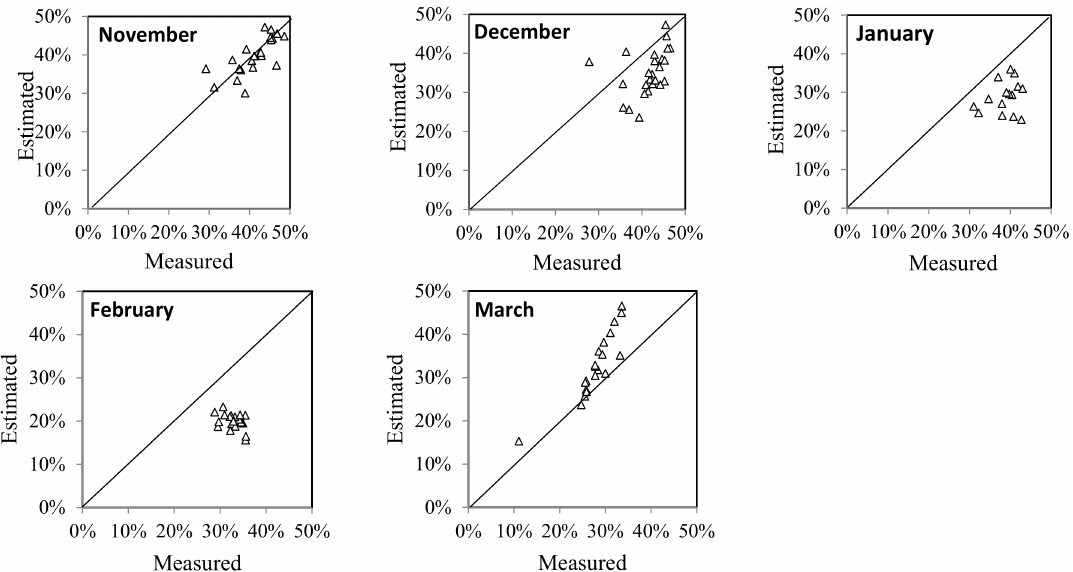
Figure 9. Correlation between the estimated and measured daily collector efficiency.